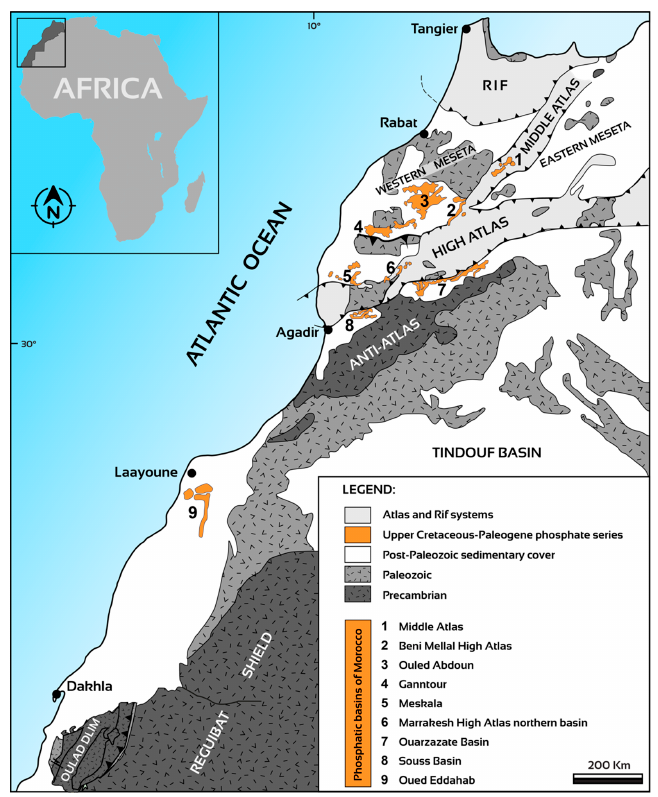
Figure 4. Simplified geological map of Morocco illustrating the distribution of phosphate accumu- lations in the different structural domains of Morocco (modified based on Piqué, 1994, [81]).